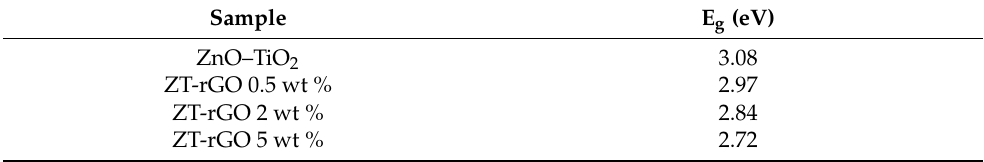
Figure 6. Normalized and transformed Kubelka–Munk function versus the light energy for the parent ZnO-TiO 2 core-shell flowers (black line, solid) and ZT-rGO at 0.5 (red line, dash), 2 (green line, dot), and 5 wt % (blue line, dash dot) rGO loading. Table 1. Calculated optical band-gap values (E g ) for the ZnO–TiO 2 and the ZT-rGO core-shell structures.